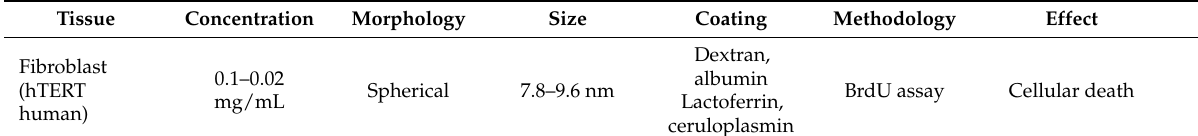
Table 2. Different biological assays in MNPs